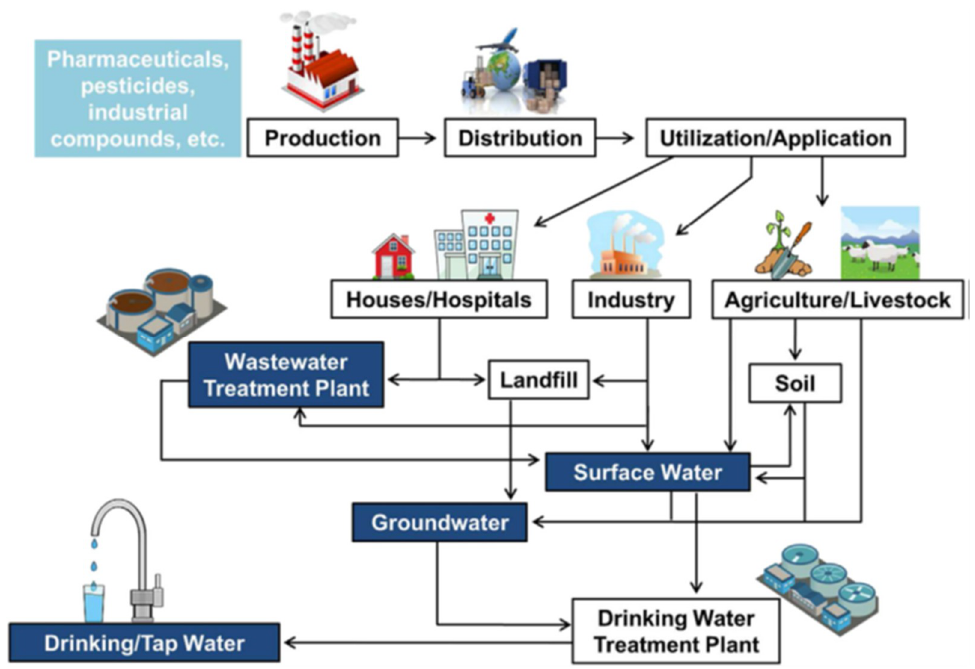
Figure 1. Representative sources and routes of micropollutants in the environment [16] . Reproduced with permission from [16], Copyright Water Research, 2016.